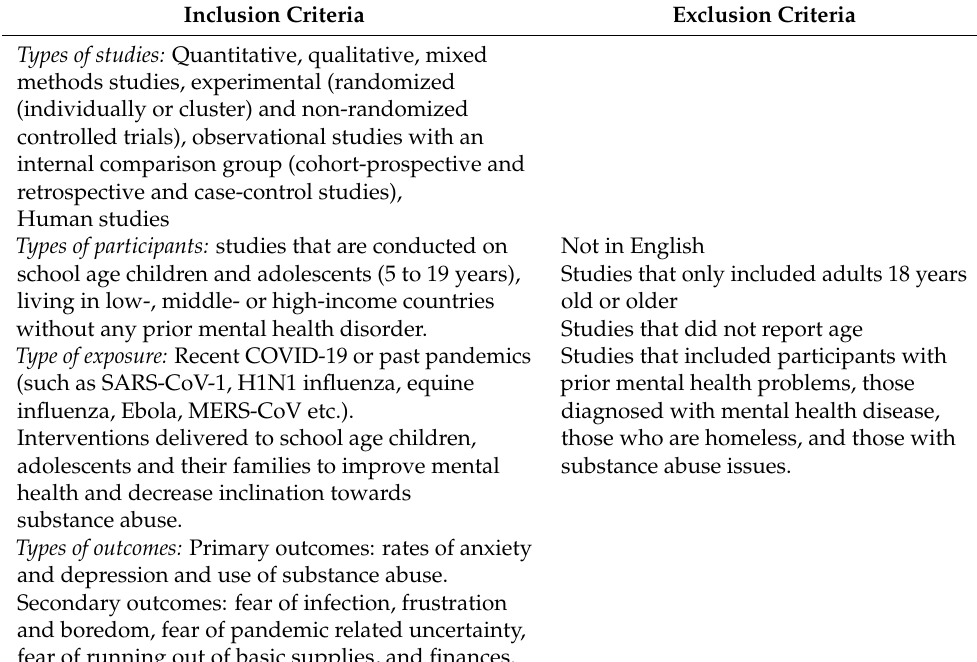
Table 1. Inclusion and exclusion